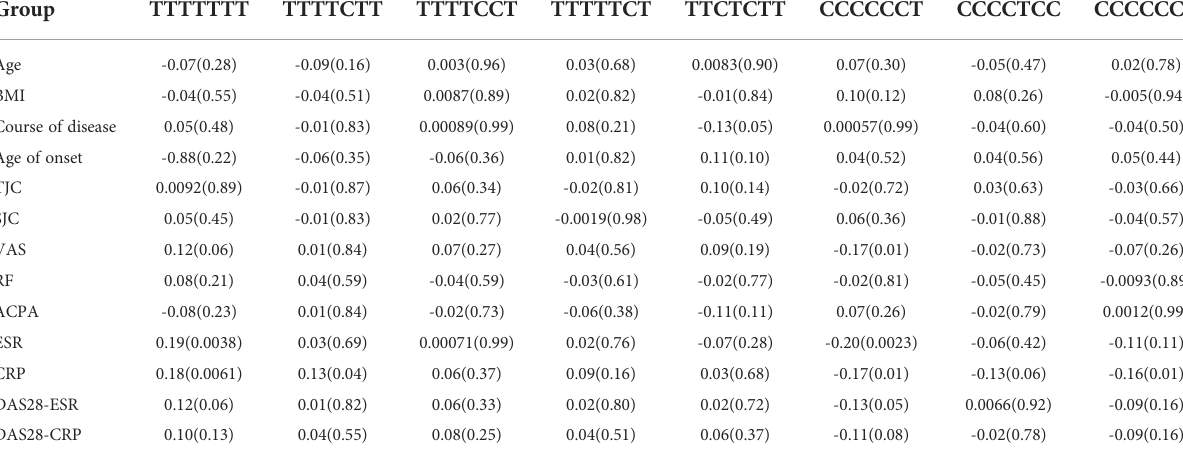
TABLE 2 Correlation analysis between the methylation level of different haplotype sites and clinical data.